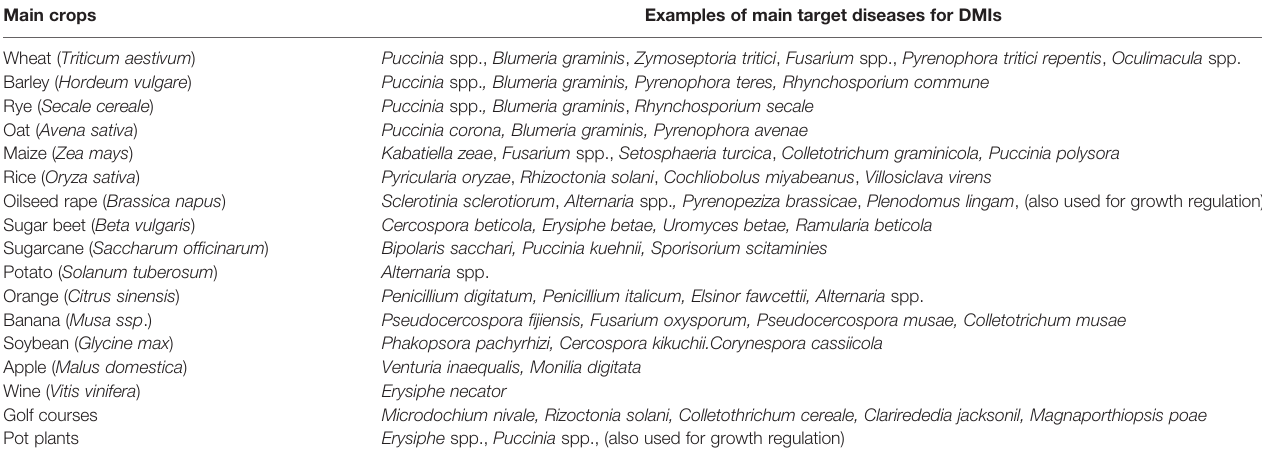
TABLE 2 | List of examples of main target diseases for which DMIs are applied. Main crops Examples of main target diseases for DMIs